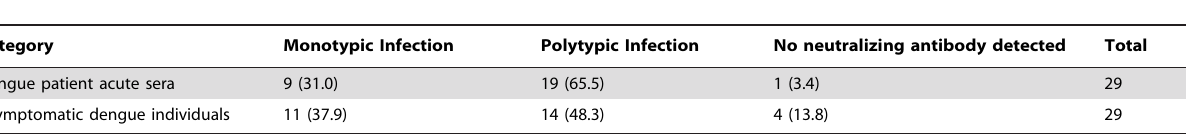
The numbers within parentheses indicate percentage. doi:10.1371/journal.pone.0092240.t003 PLOS ONE |